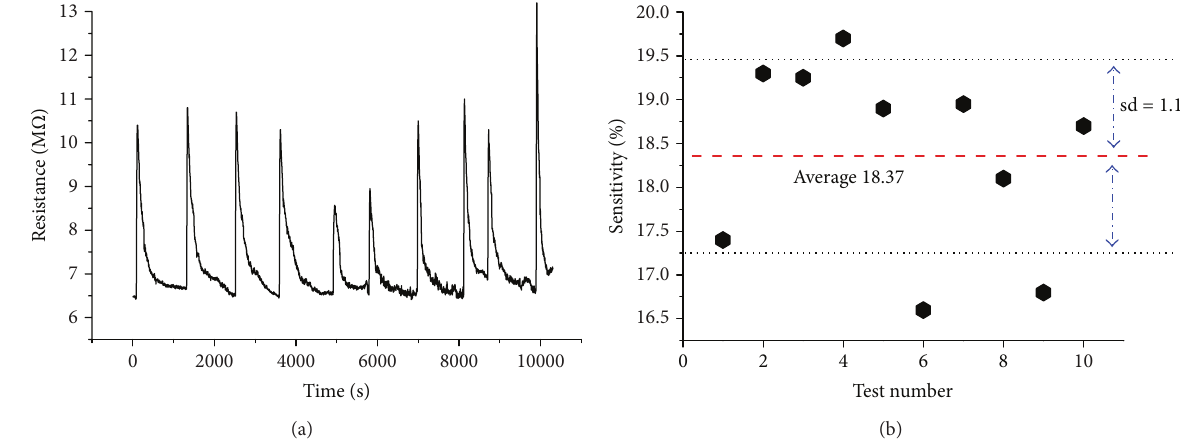
Figure 5: For the MST-3c sample: (a) MST experiment to 0.4 mL THF and (b) reproducibility to the MST experiment at 0.4mL of THF for the same